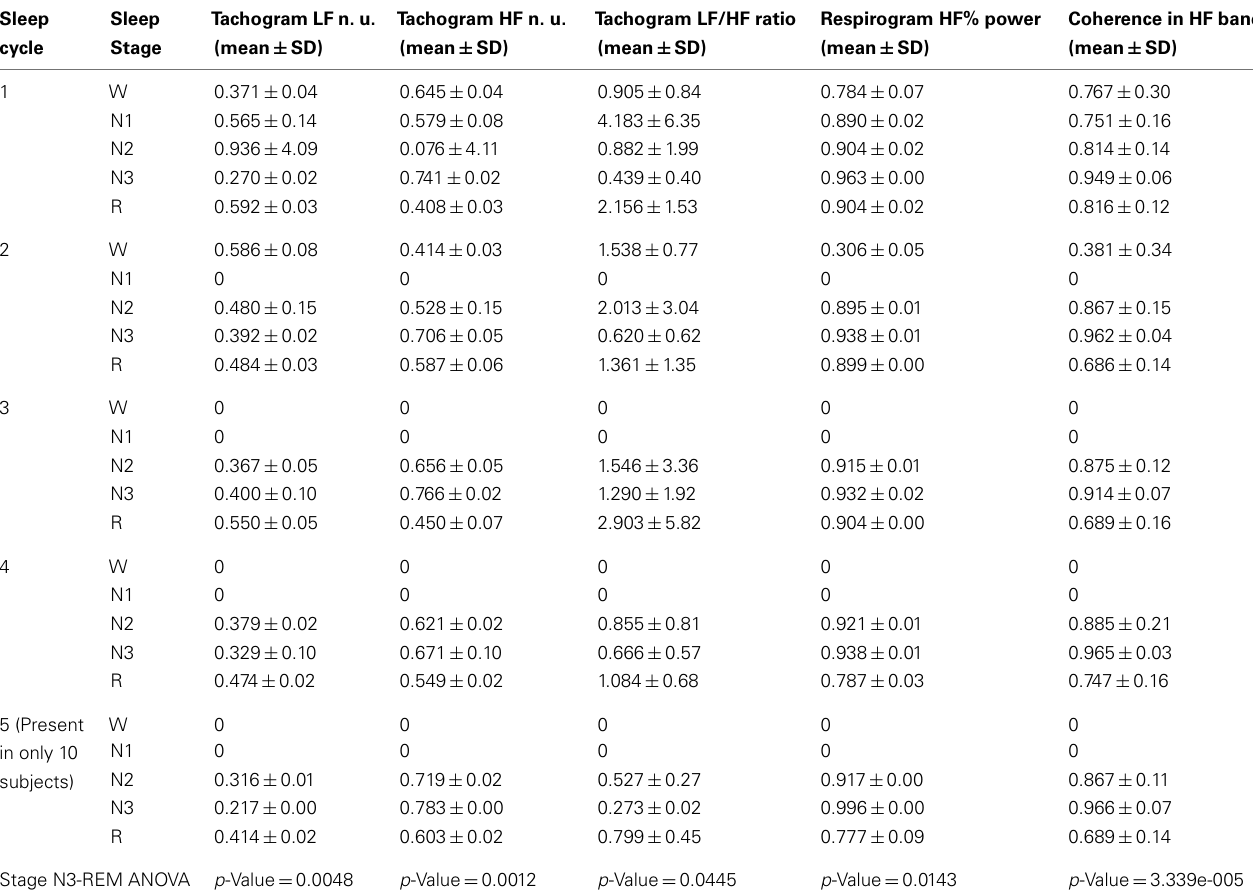
Table 1 |Average values of the tachogram normalized power in the LF and HF bands, of the LF/HF ratio values, of the respirogram % power in the HF band and of the tachogram–respirogram coherence in the HF band values observed on all subjects during each stage of each sleep